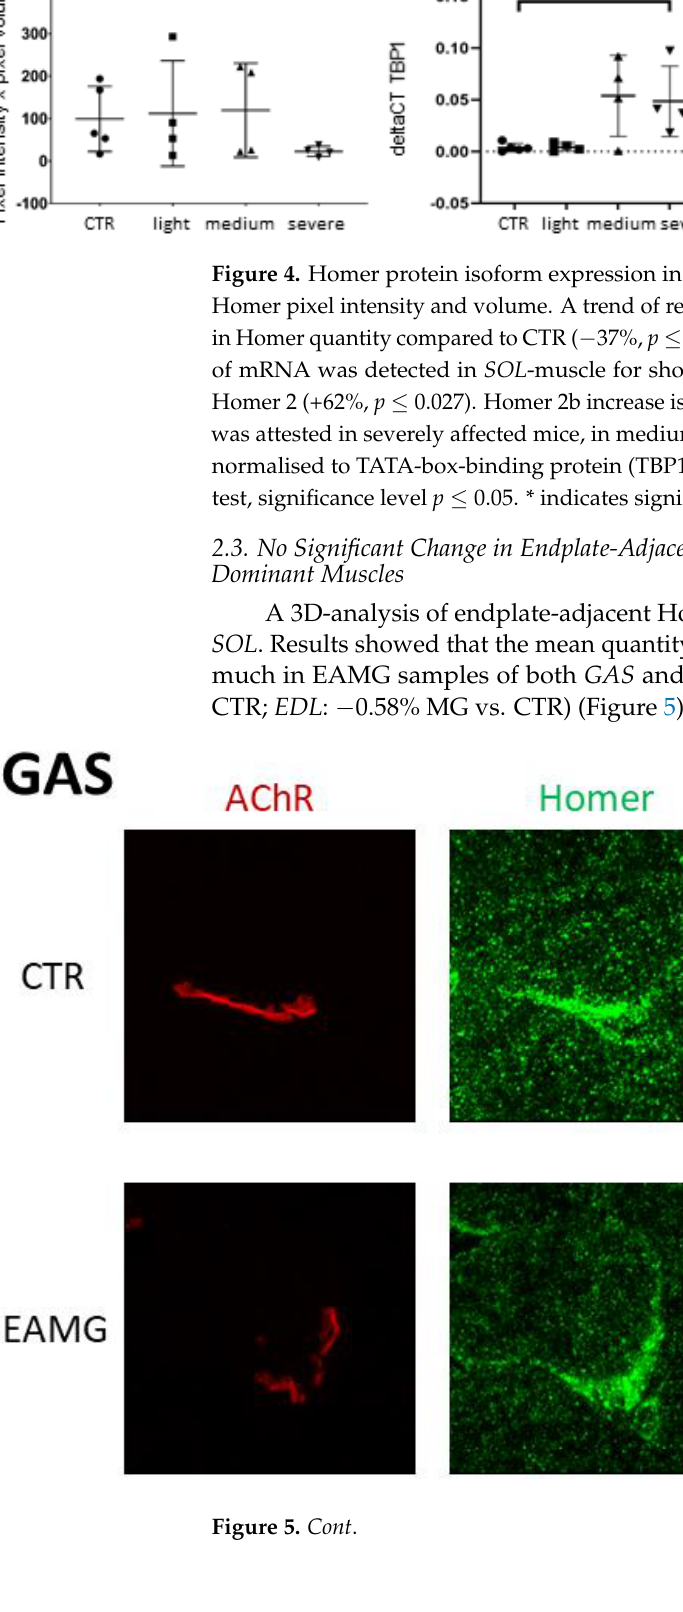
Figure 5. Representative immunohistochemical staining of GAS and EDL muscle endplates and end- plate-adjacent Homer protein. For each image block (GAS, EDL) upper panel CTR, lower panel EAMG group. From left to right is shown nAChR-staining ( red ), Homer staining ( green ) and a merged image of both staining. No significant changes between CTR and EAMG are observed in 3D analysis in neither EDL nor GAS in Homer endplate staining. Magnification bar = 10 µm.